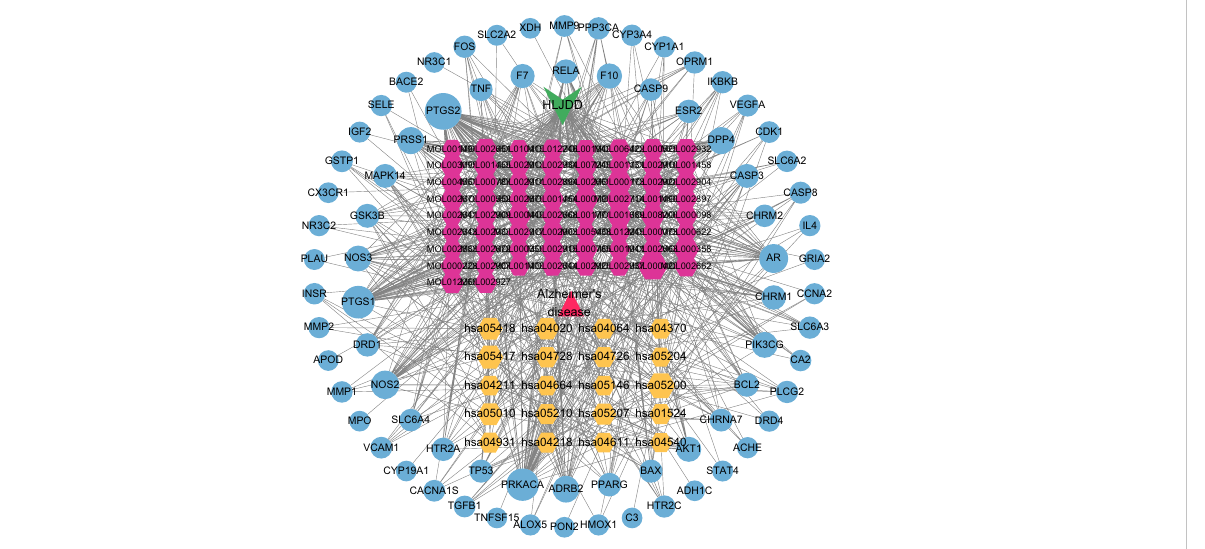
FIGURE 7 H-C-T-P-D network diagram. Triangle represents disease; V is HLJDD; The yellow hexagon is the KEGG pathway; The red hexagon is the active ingredient of the drug; The blue circle is the target.